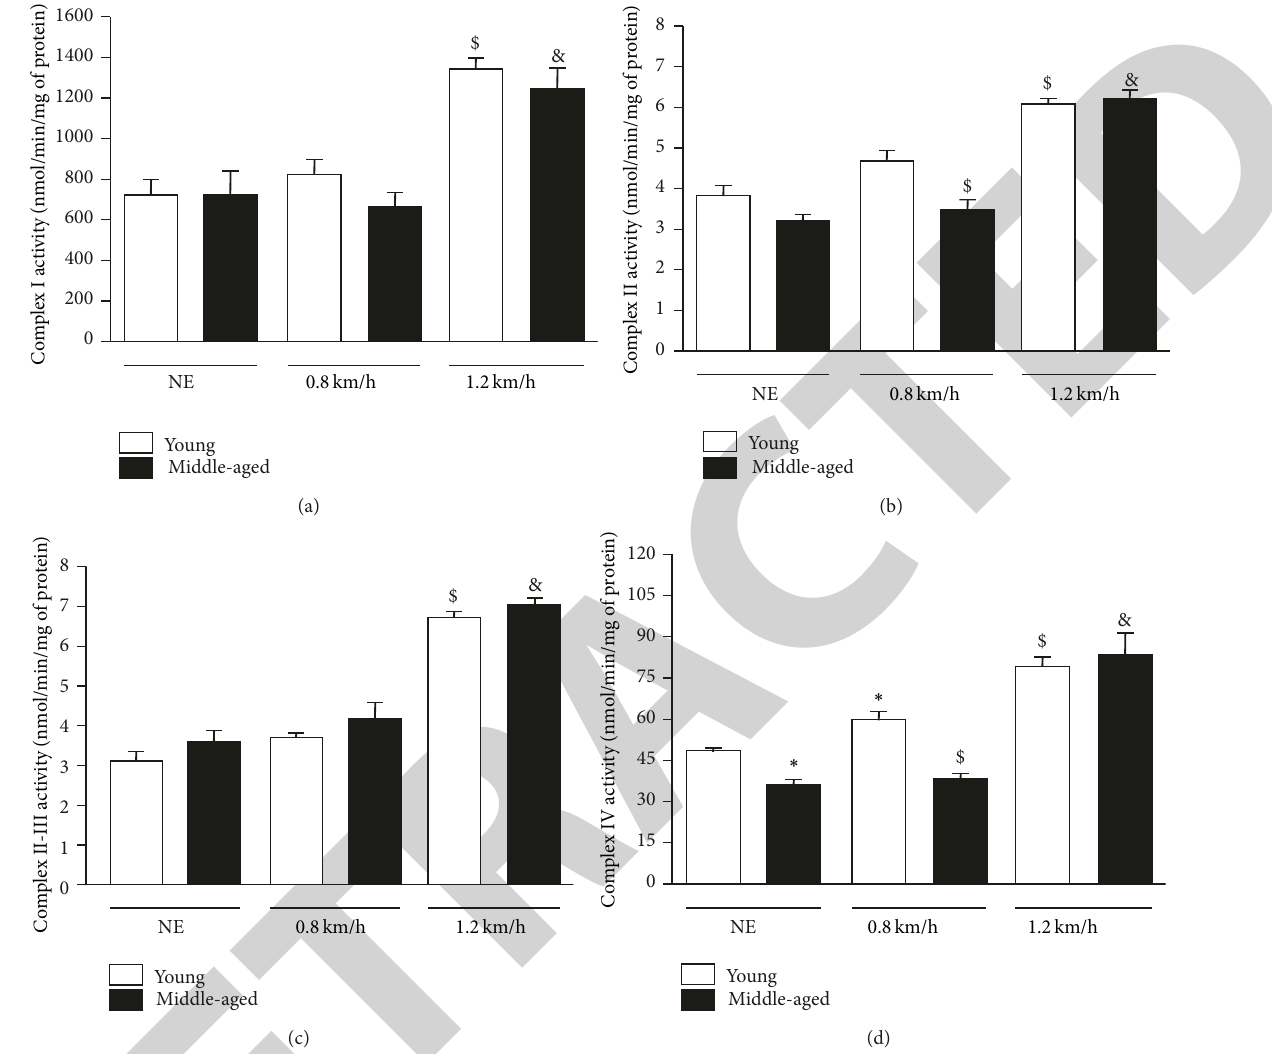
Figure 4: Effects of exercise protocols performed in different intensities on the complexes I, II, II-III, and IV activities in the quadriceps of young and middle-aged rats. Complexes I (a), II (b), II-III (c), and IV (d) activities are expressed as nmol/min/mg of protein. ∗ 𝑃 < 0.05 versus young NE rats, # 𝑃 < 0.05 versus middle-aged NE rats, $ 𝑃 < 0.05 versus young rats at 0.8 km / h, and & 𝑃 < 0.05 versus middle-aged rats at 0.8 km /